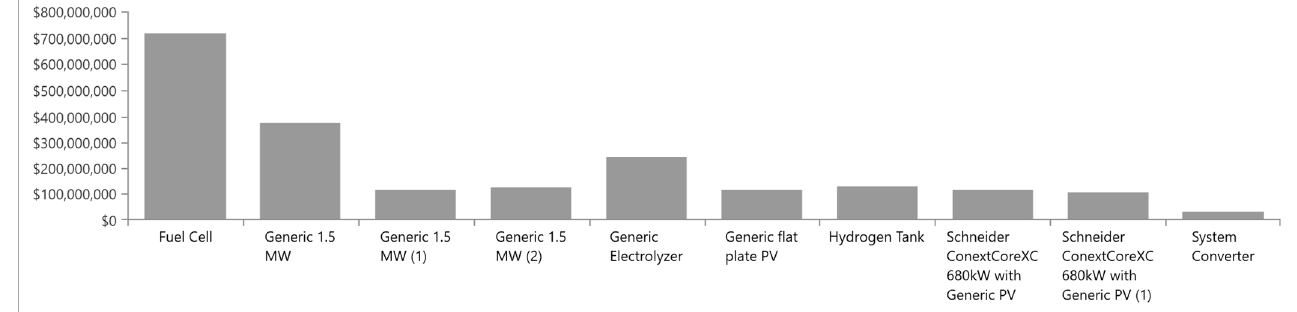
Figure 7. Net present value (NPV) for each system component.